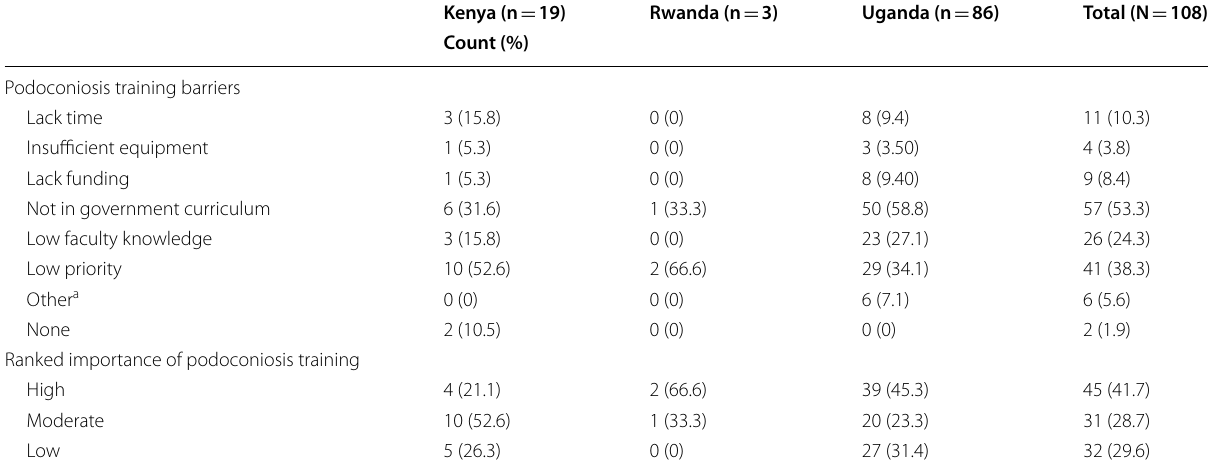
Table 5 Perceived barriers to inclusion of podoconiosis content in nursing curriculum and ranked importance of podoconiosis training (N =